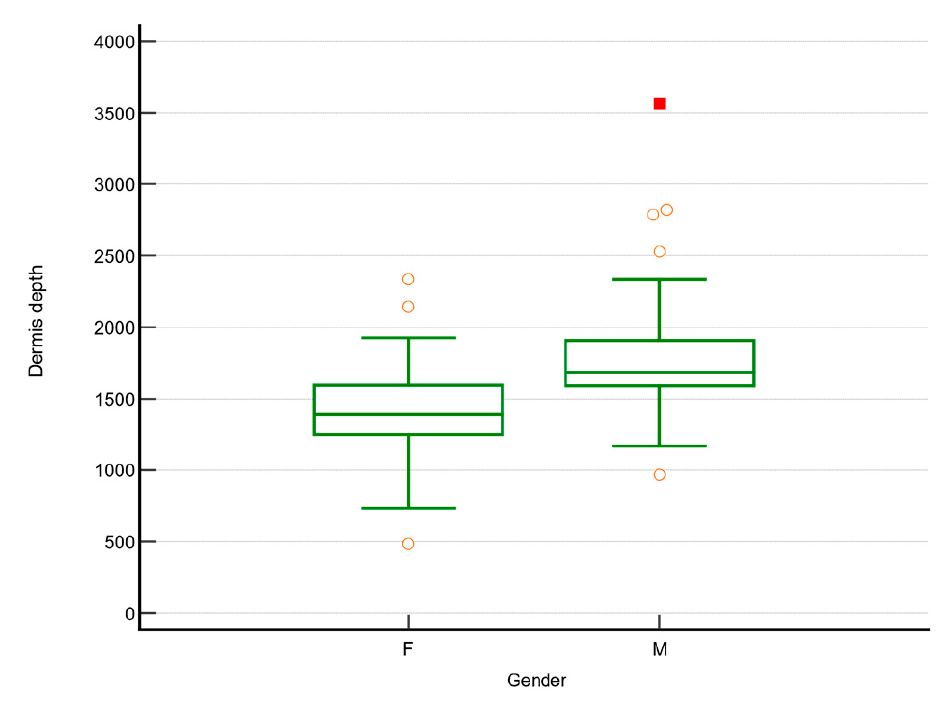
Figure 6. Dermis depth in females and males. When correlating the skin phenotype with the ultrasound measurements, patients with type IV phenotype had thicker dermis ( p = 0.013) and a higher no. of pixels in the dermis ( p = 0.012) compared to type II or III phenotypes. At the non-sun-exposed sites (lower lip mucosa), there was a significant difference regarding the depth of non- keratinized epithelium ( p = 0.008) and pixel count ( p = 0.035) in patients with type IV phenotype compared to types II and III (Table 3). Table 3. HFU assessment of lower lip mucosa according to skin